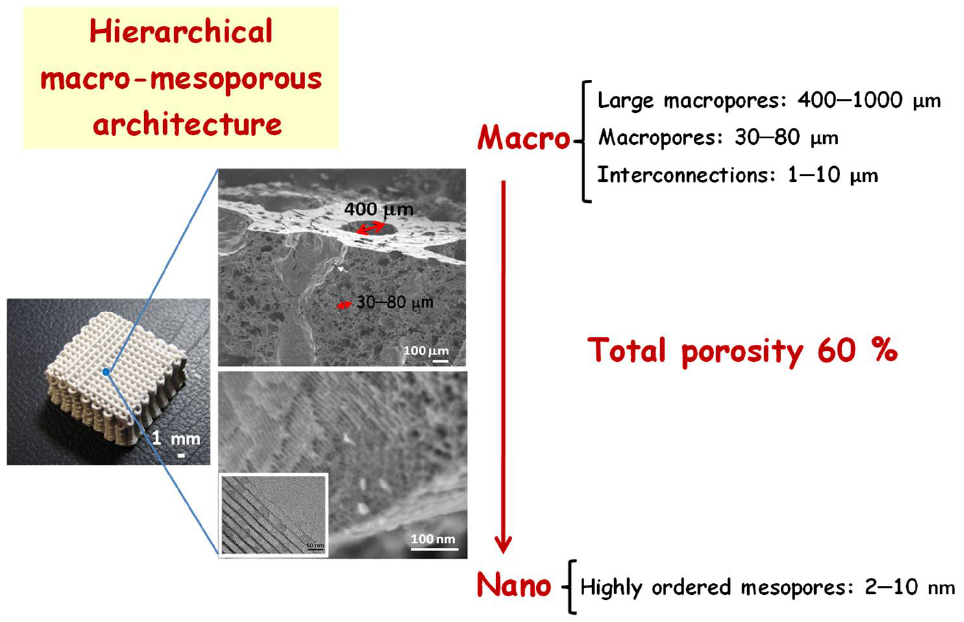
Figure 5. Hierarchical macro-mesoporous architecture of MBG-based 3D scaffolds manufactured by rapid prototyping. Up: SEM micrograph showing the hierarchical macroporosity. Down: high-resolution SEM micrograph and TEM image (as an inset) showing the ordered mesoporous arrangement. Reproduced (adapted) from reference [110]. Copyright 2014 The Royal Society of Chemistry.